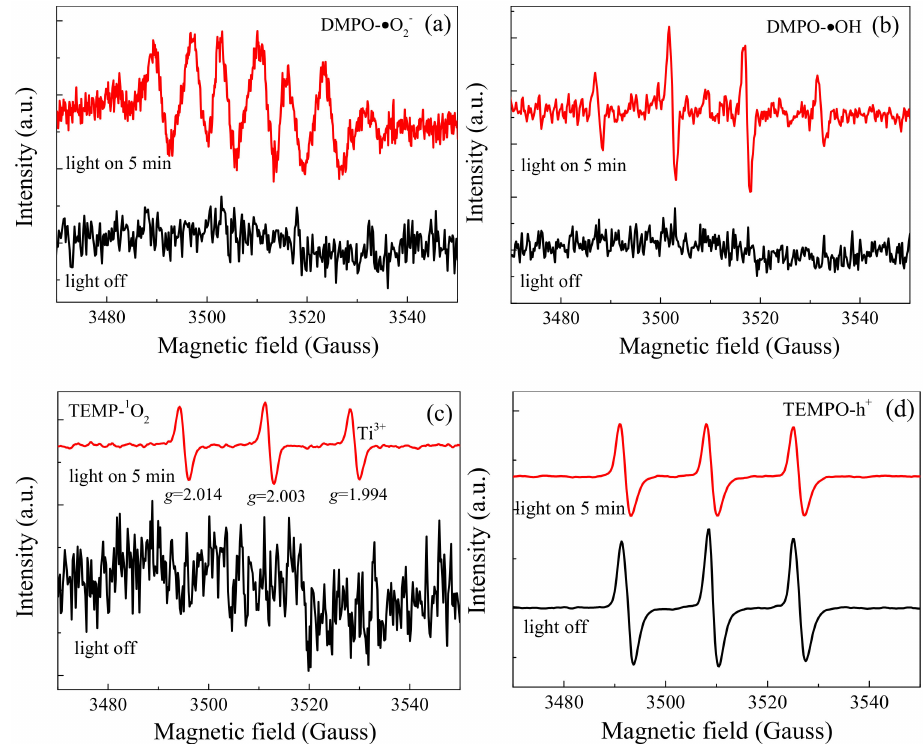
Figure 6. EPR spectra of ( a ) • O 2 − , ( b ) • OH, ( c ) 1 O 2 , and ( d ) h + for the WT powders under visible light